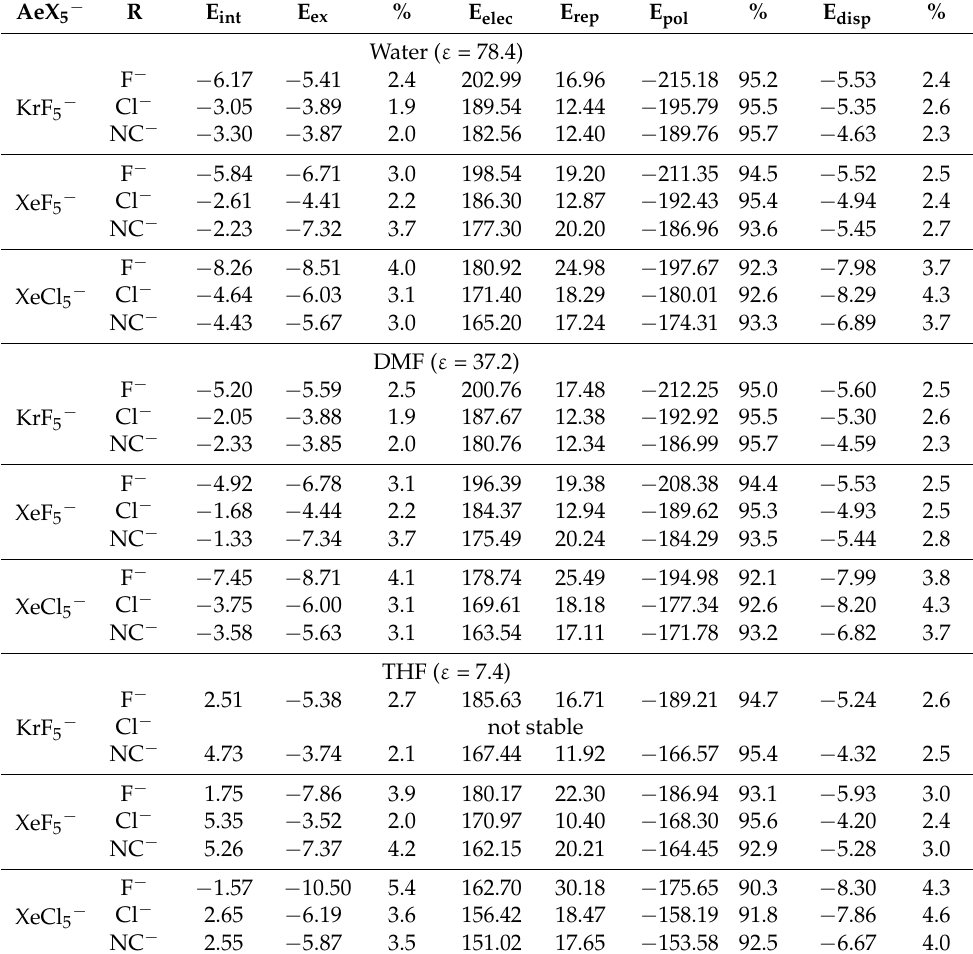
Table 4. Decomposition of interaction energy (kcal/mol) by LMOEDA scheme calculated at M06- 2X/aug-cc-pVDZ level. Dissection terms are as follows: exchange (E ex ), electrostatic (E elec ), repulsion (E rep ), polarization (E pol ) and dispersion (E disp ) a